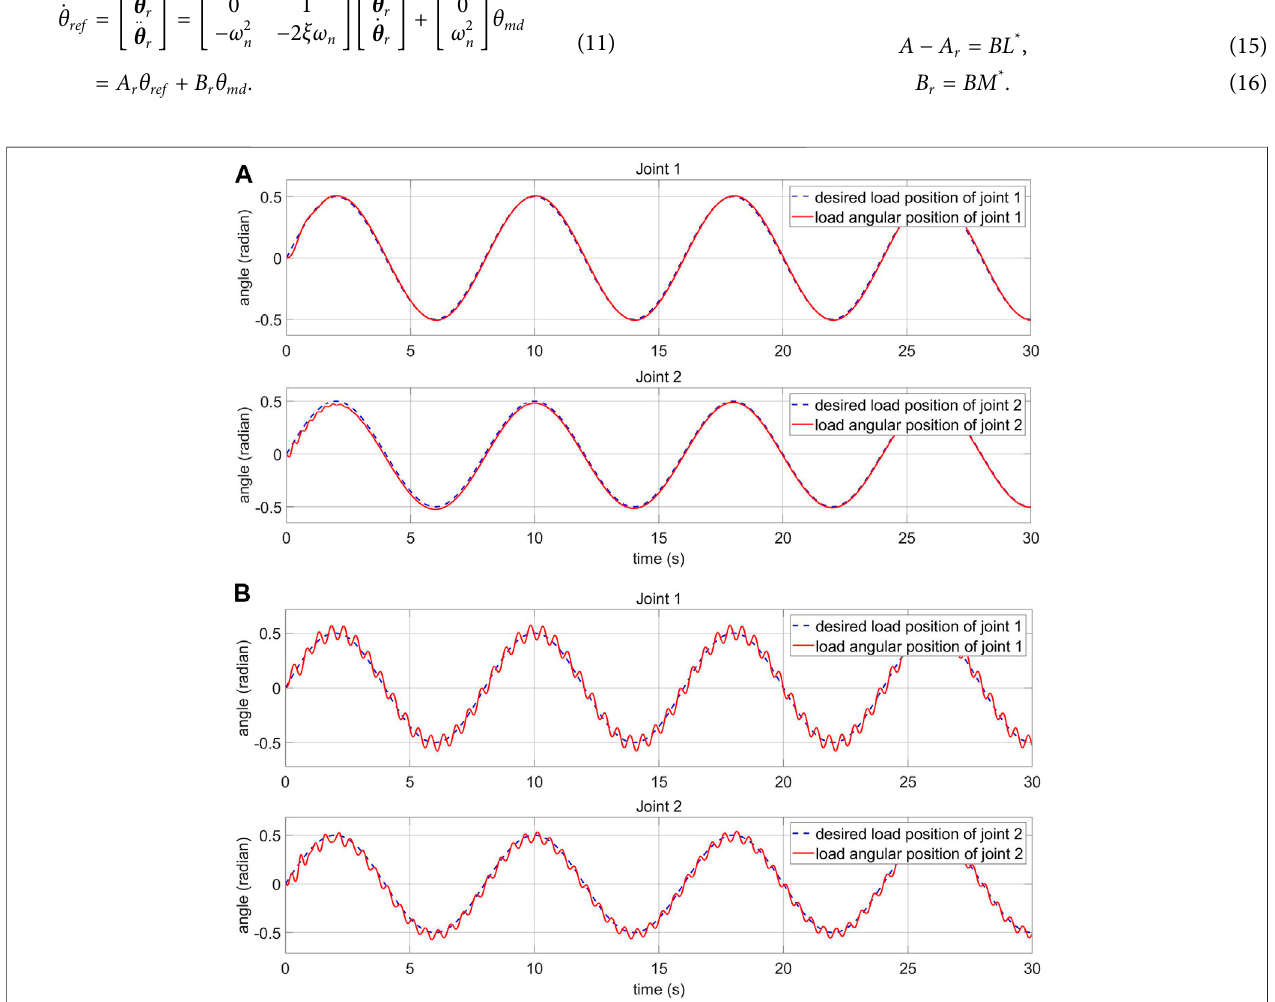
FIGURE 13 | Load-side response of the PID controller of the robot arm (A) in normal condition (B) with external disturbance.